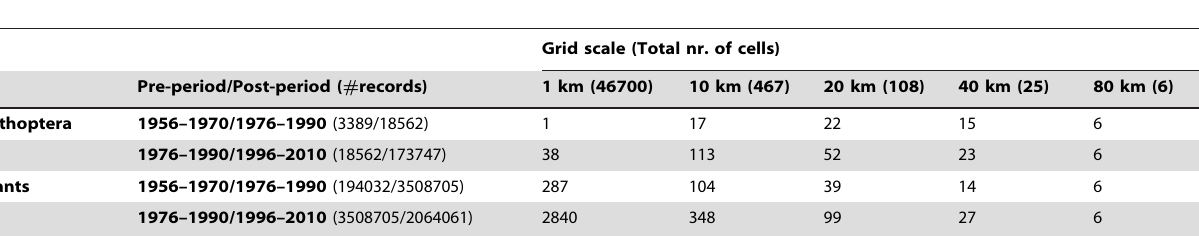
Table 1. Orthoptera and plant data: Number of grid cells resulting from the criteria (see text of methods section) applied.